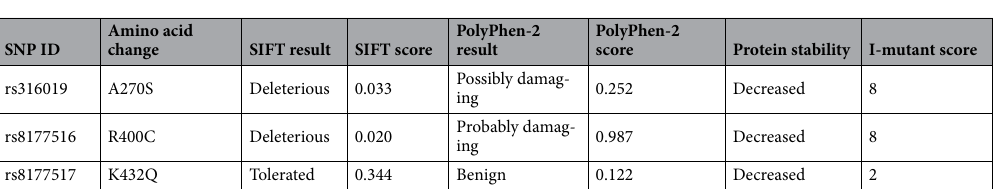
Table 3. Phenotypic effects predicted for aa substitutions identified in a South African Xhosa population on the structure and function of SLC22A2 using SIFT, Polyphen-2 and I-mutant algorithms. Aa one-letter code: A alanine, S serine, R arginine, C cysteine, K lysine, Q glutamine. SIFT score: 0 = deleterious, 1 = neutral/tolerated; PolyPhen-2 score: 0–0.14 = benign, 0.15–0.84 = possibly damaging, 0.85–1 = probably